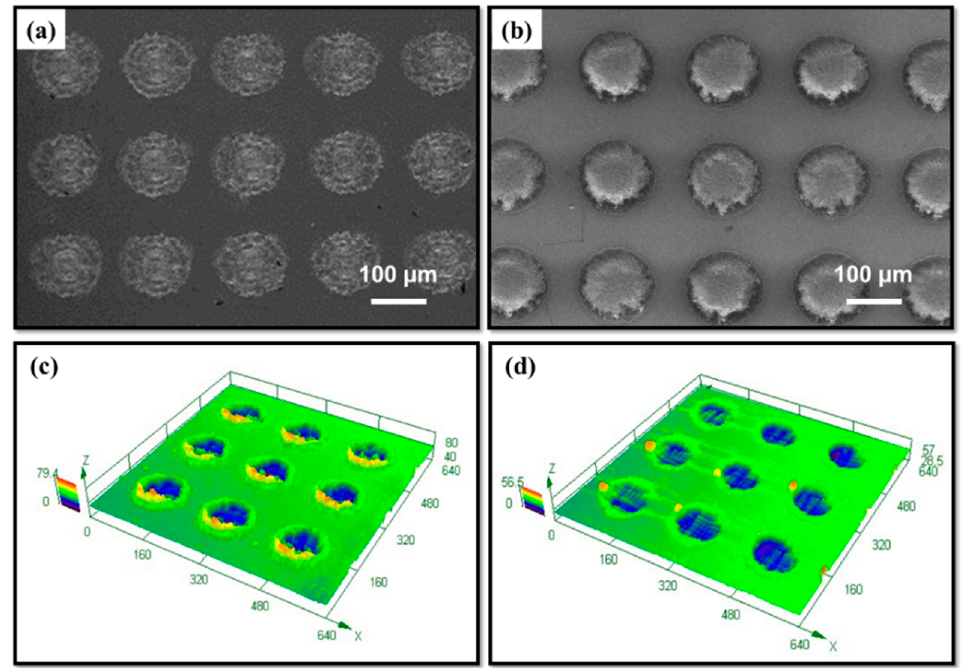
Figure3. SEMmorphologiesofthetexturedsurfaces( a , c )withoutCSgraftingand( b , d Figure 3. SEM morphologies of the textured surfaces ( a , c ) without CS grafting and ( b , d ) with CS grafting.